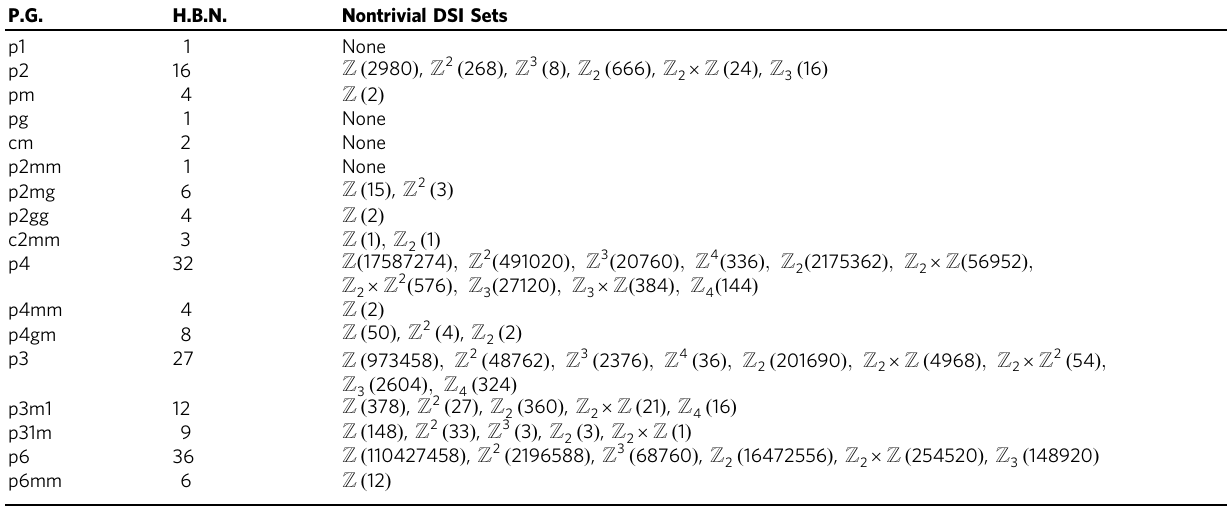
Table 2 Numbers of Hilbert bases and nontrivial DSIs for all spinful 2D plane groups. P.G.